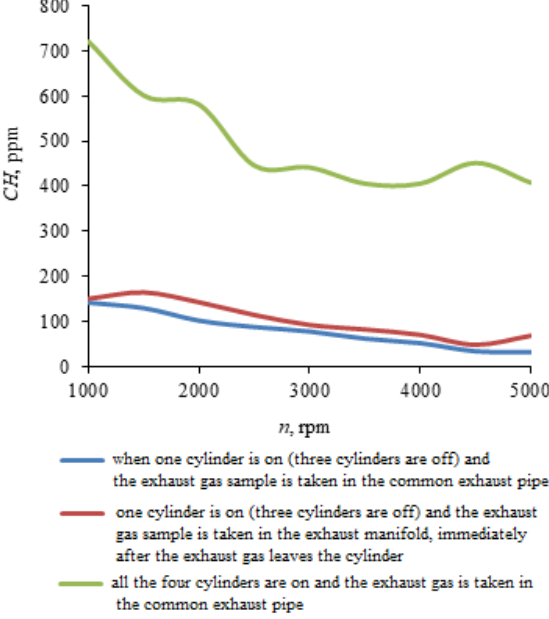
Figure 13. The dependence of the CH concentration in the exhaust gases on the ICE crankshaft speed